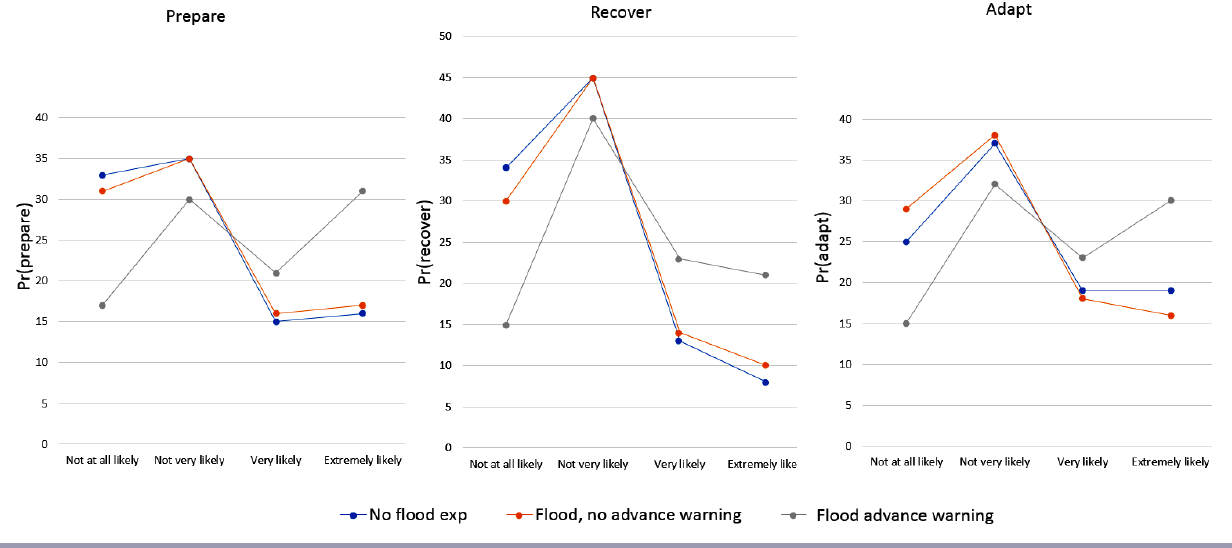
Fig. 4 . Predicted probability of capacity to prepare, recover, and adapt to an extreme flood event, based on early warning of that event. Marginal effects computed on the basis of the separate ordinal logistic